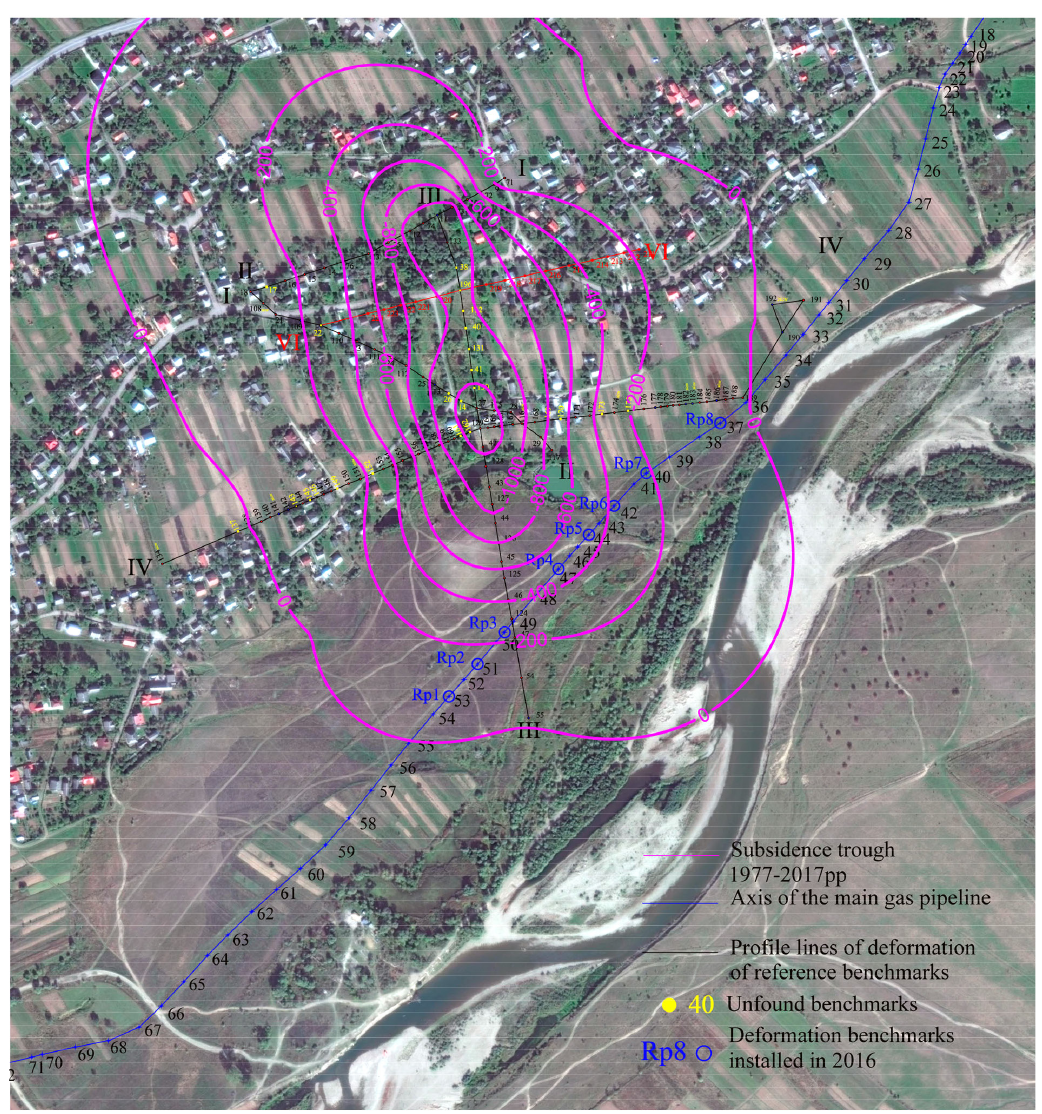
Figure 1. Map of the placement of profile lines of deformation of reference benchmarks, the axis of the main gas pipeline and the subsidence